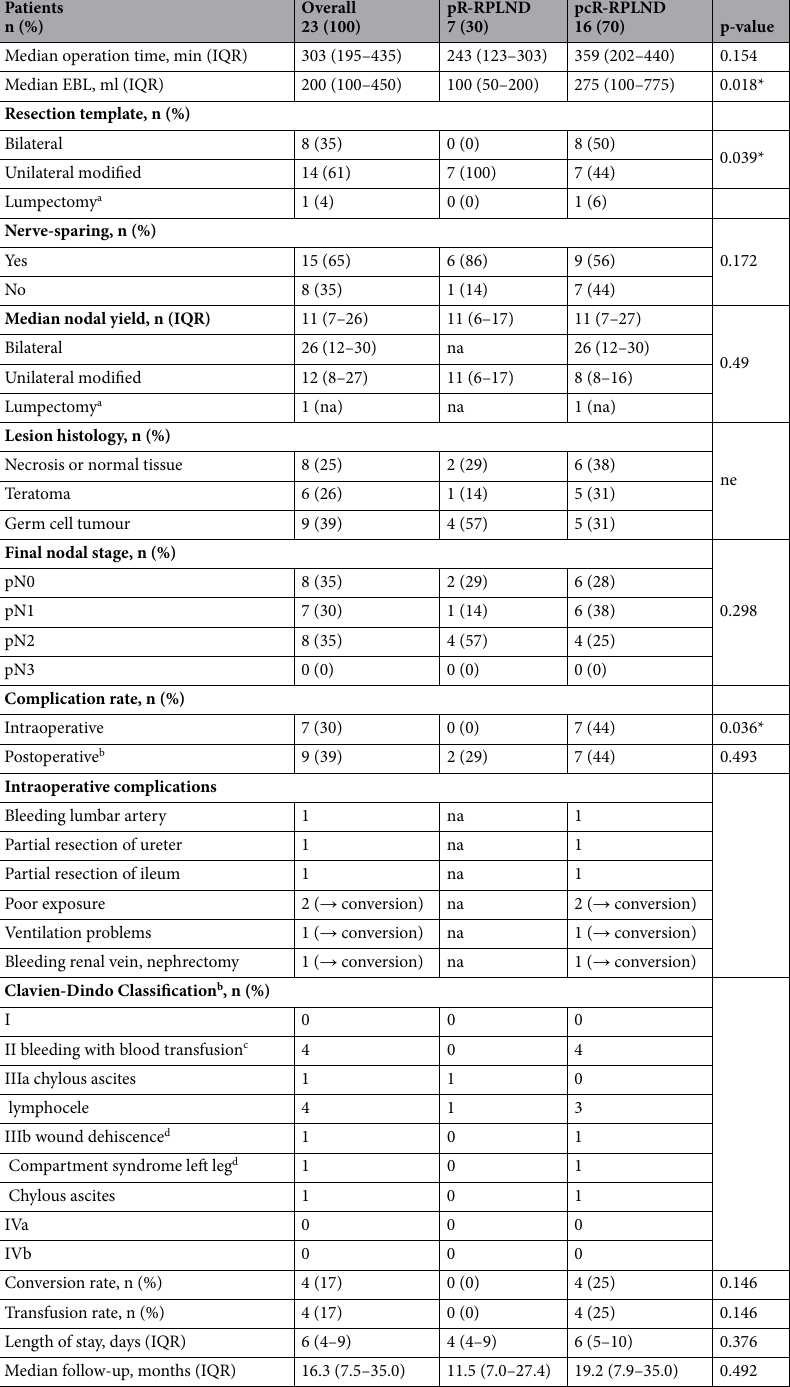
Table 2. Peri- and postoperative patient outcome. pR-RPLND primary robotic retroperitoneal lymph node dissection, pcR-RPLND post-chemotherapeutic robotic retroperitoneal lymph node dissection, n patient number, IQR interquartile range, EBL estimated blood loss, na not applicable, ne not evaluated. *Statistically significant p < 0.05. a Lumpectomy was performed in one patient with hemodynamic relevant compression of the caval vein by residual tumour of a seminoma. b Complications within 90 d postoperatively according to Clavien-Dindo Classification. c Three of them converted patients. d Converted